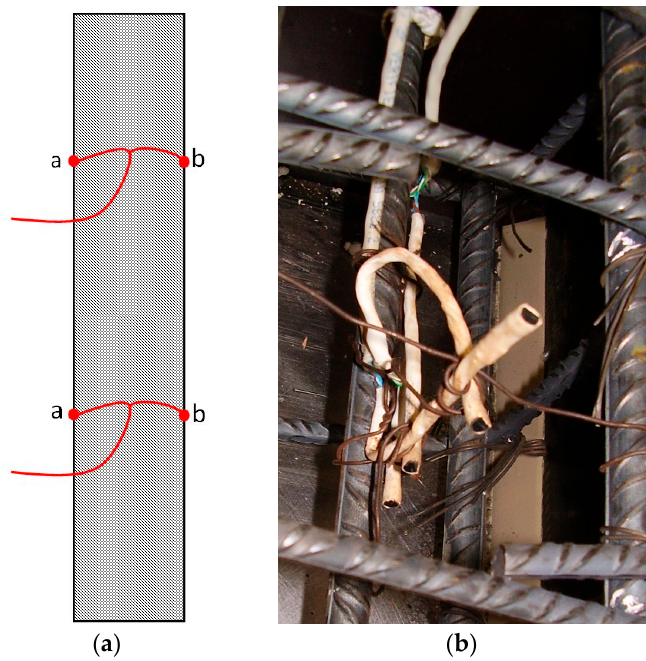
Figure 1. ( a ) Location of the surface temperature sensors on the panel; ( b ) detail of a surface temperature sensor before concrete casting.